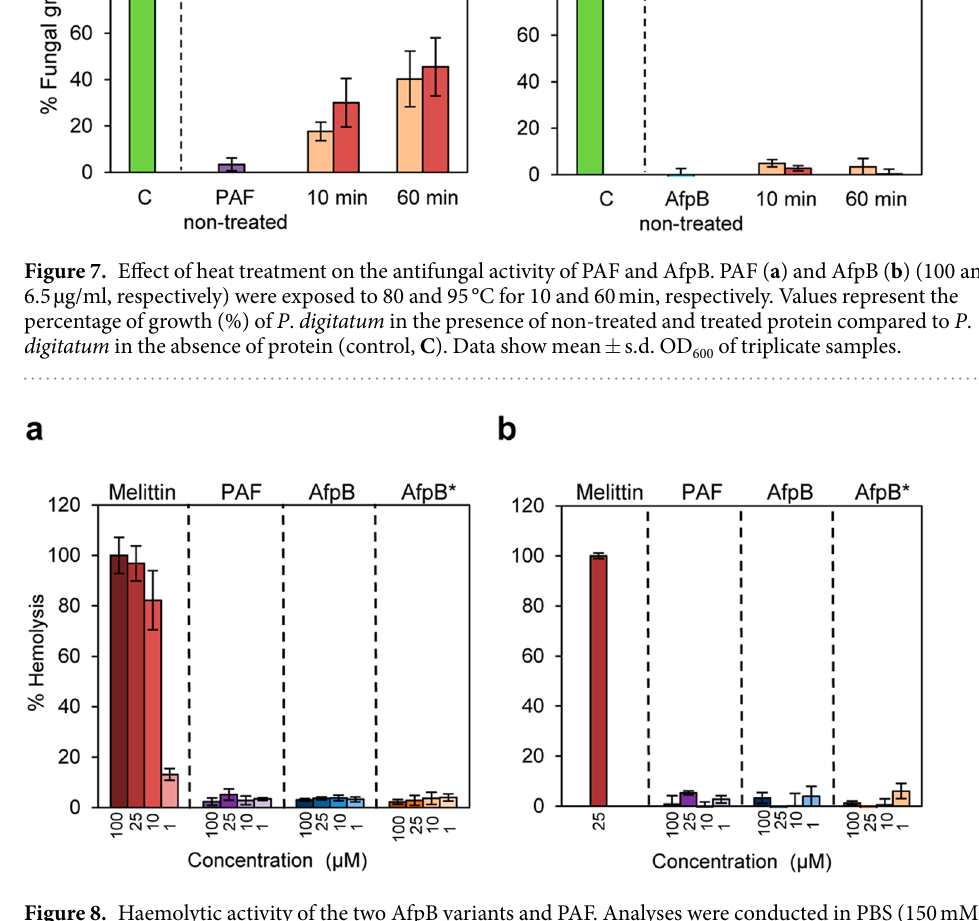
Figure 8. Haemolytic activity of the two AfpB variants and PAF. Analyses were conducted in PBS (150 mM NaCl) ( a ), and in PBG (250 mM glucose) ( b ). Proteins were used at the concentrations indicated (from 1 to 100 µ M). The cytolitic peptide melittin was included for comparison. The haemolytic activity is given as the mean ± s.d. of the percentage of human RBCs haemolysis (three replicates), as compared with the positive control in the presence of the detergent Triton X-100 (regarded as 100%